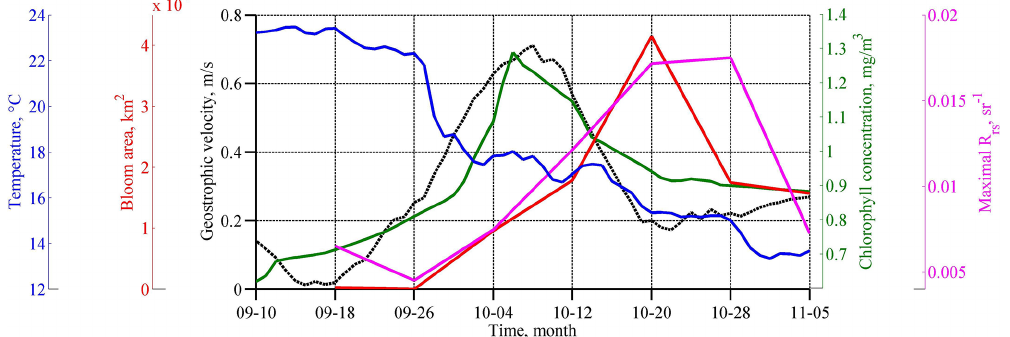
Figure 3. Temporal evolution of SST (degrees Celsius; blue line), R rs (per steradian; purple line), and Chl (milligrams per cubic meter; green line) averaged in the western central part of the basin (see black rectangles in Fig. 5c, d), which is the area of coccolithophore bloom (square kilometers; red line) as computed only. Geostrophic velocity (meters per second; black dashed line) over the Black Sea continental slope is shown at the point 41.9375 ◦ N and 28.4375 ◦ E; see the white star in Fig.